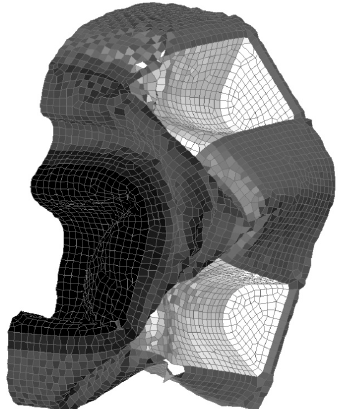
Figure 29. D3Plot image of damage after impact of LS-Dyna model with settings All Slim = 1.0, TSize = 1 × 10 − 9 , Erods = 1.0, Soft = 0.0 and FS = − 1.0.